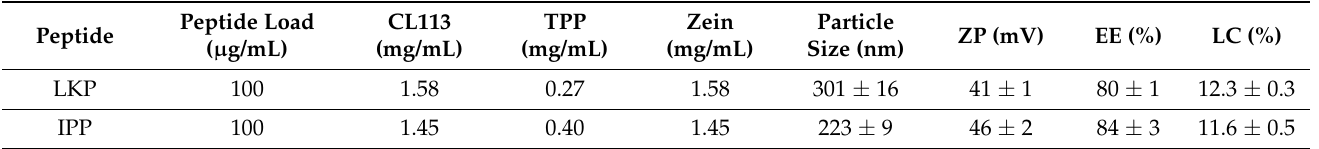
Table 2. Physicochemical characteristics of LKP/IPP CZ NP at the optimal ratios of CL113: TPP and